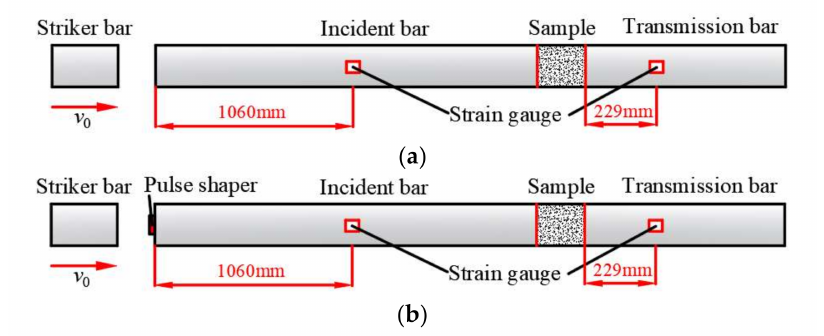
Figure 21. Diagrammatic sketch of SHPB test device. ( a ) Conventional SHPB ( b ) Modified SHPB.